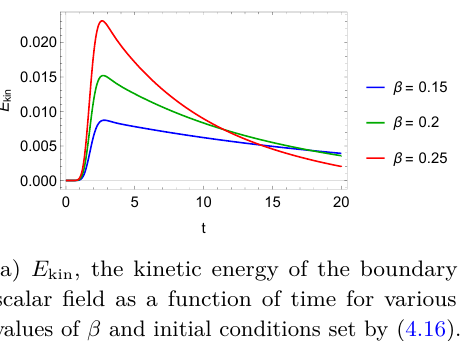
Figure 12 . The kinetic energy of the boundary scalar field and that of the holographic sector as a function of time for various values of β and initial conditions set by (4.16). The sum is conserved. Higher values of β lead to larger energy extraction from the black brane by the boundary scalar field but then the energy is returned back to the black brane irreversibly and completely at a higher rate. The time t max at which the boundary scalar field attains its maximum energy E max is independent of β and is ≈ 2 . 9 as shown in the table